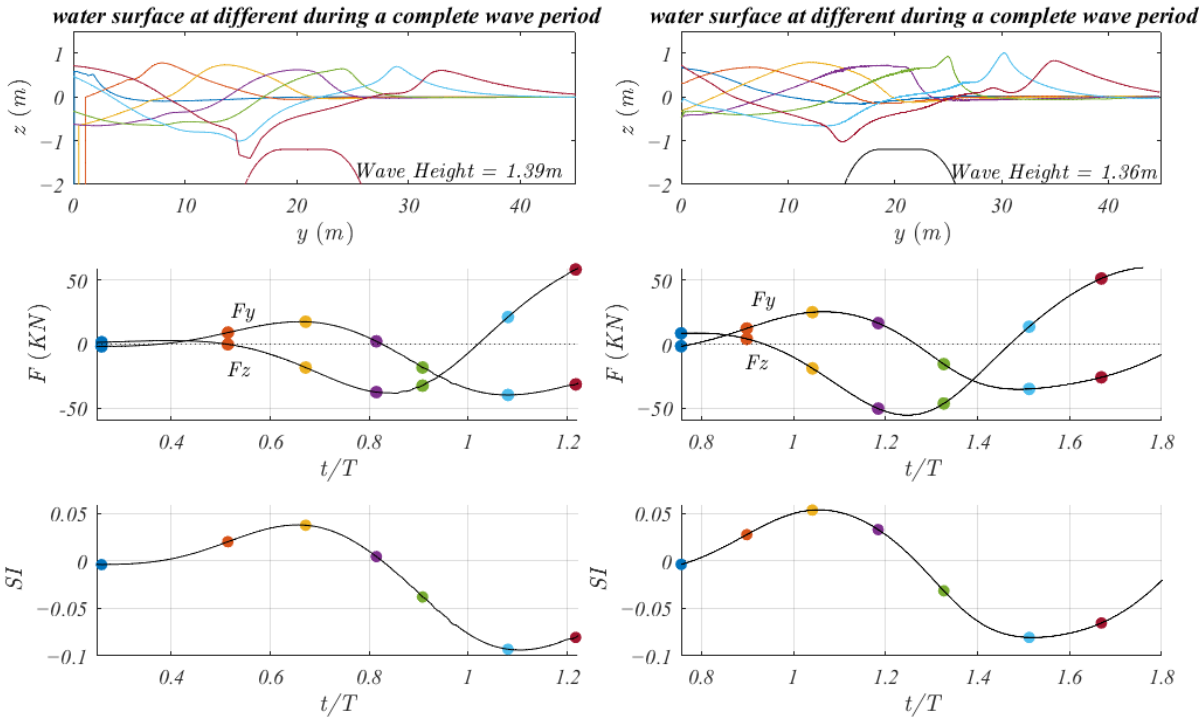
Figure 7. Water surface elevations, loads and SI for wave height 1.3 m and 1.27 m , T = 7 s , as obtained by BELWF (left) and by OpenFOAM (right), respectively.